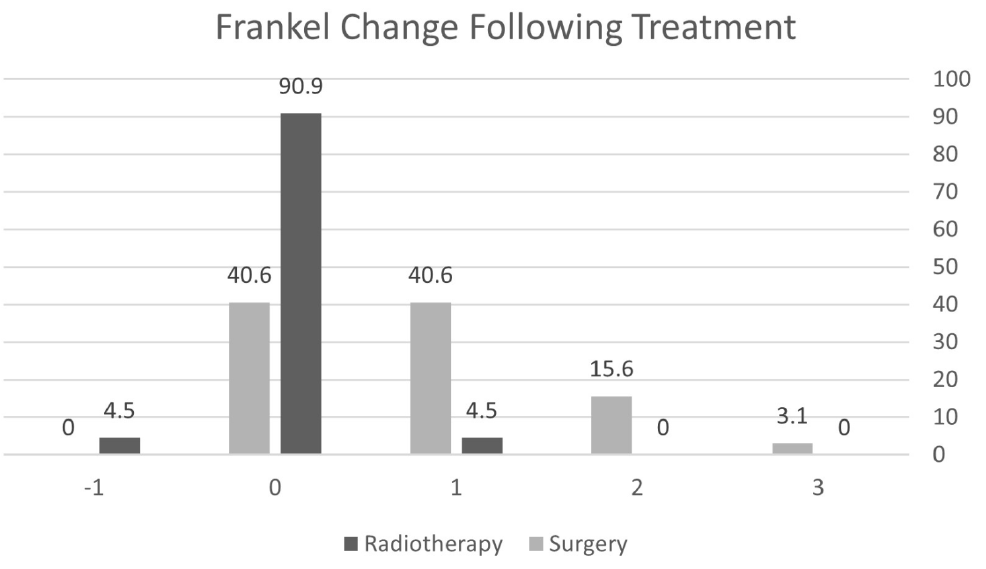
Figure 3. Change in Frankel score following treatment. Table 3. Change in ambulation following treatment.